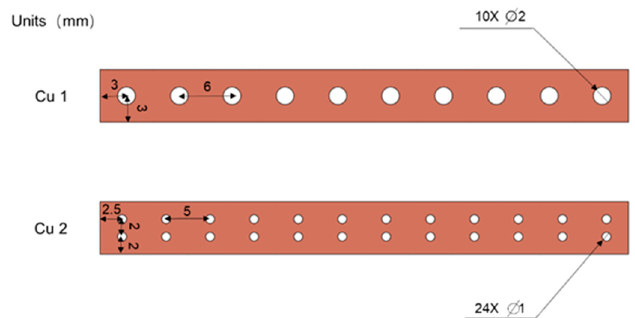
Figure 5. Schematic diagram of the size of the round hole metal strip .